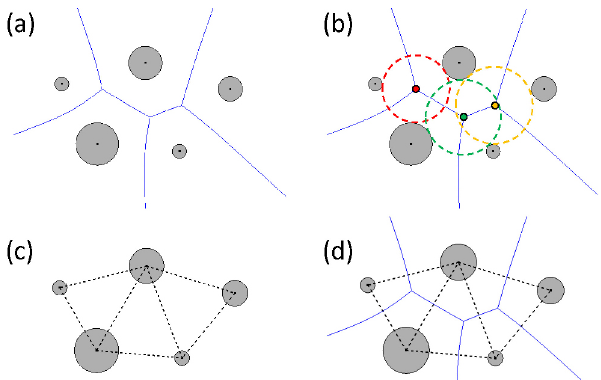
Fig. 5 Voronoi diagram and dual triangulation of a set of input circles with different radii: (a) Voronoi diagram, (b) Voronoi vertices and corresponding circumcircles, (c) dual triangulation of the same input, (d) superimposed Voronoi diagram and dual triangulation, illustrating their duality.